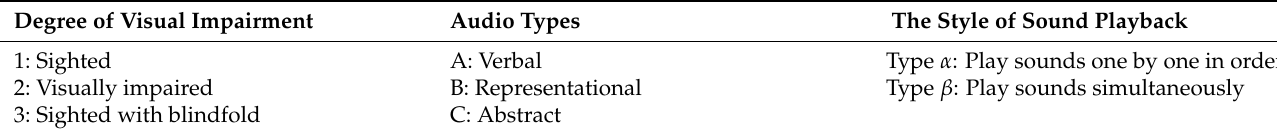
Table 3. The composition of valuable